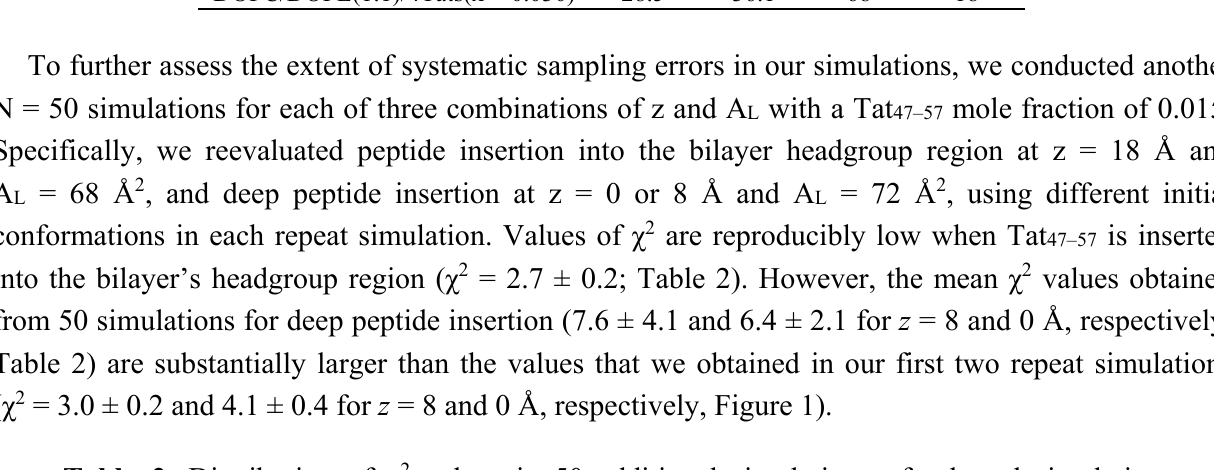
Table 2. Distribution of χ 2 values in 50 additional simulations of selected